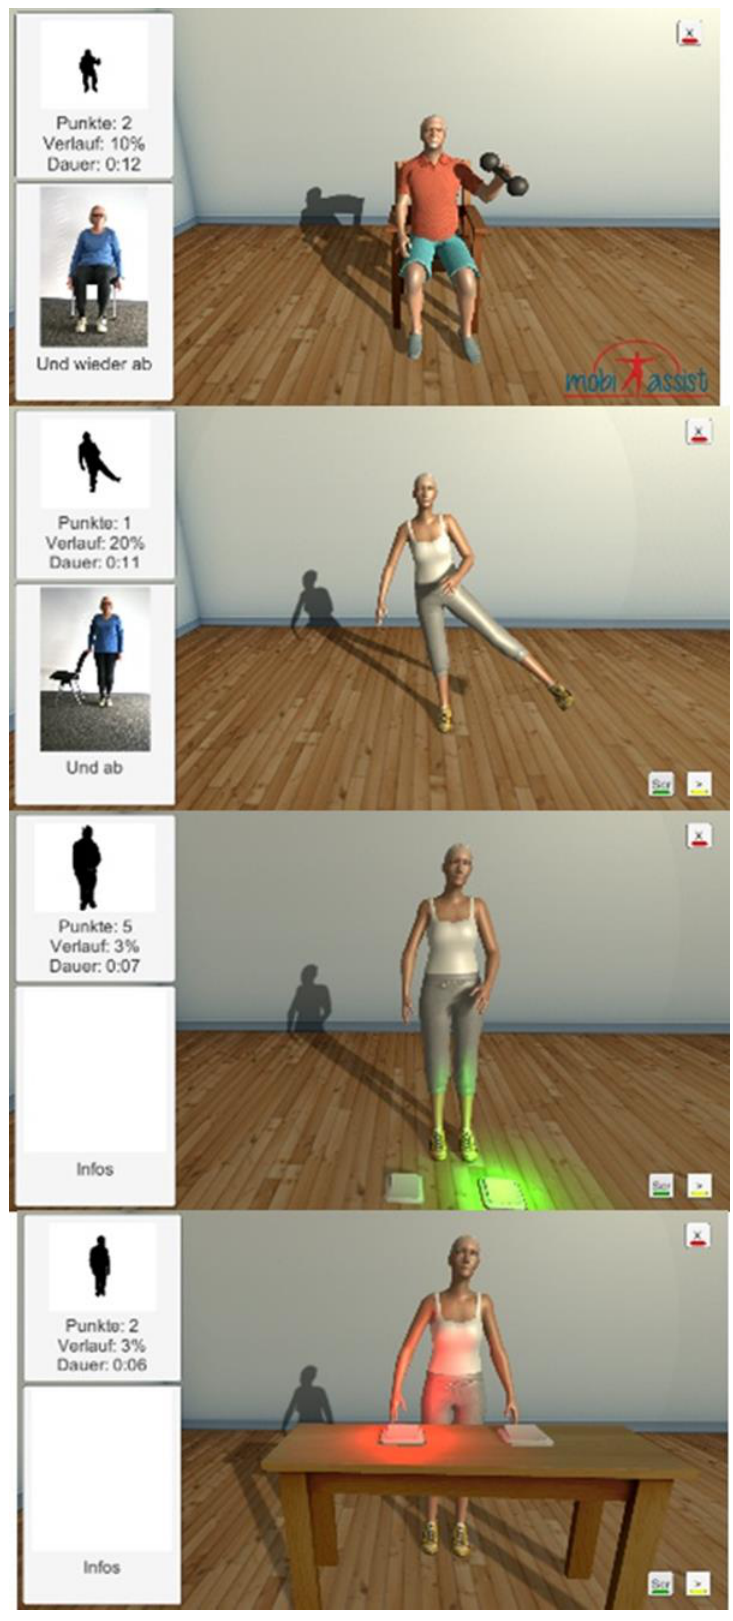
Figure 7. Integrated assessments in the MobiAssist ICT-based System. (Permission granted by David. Unbehaun) 65].